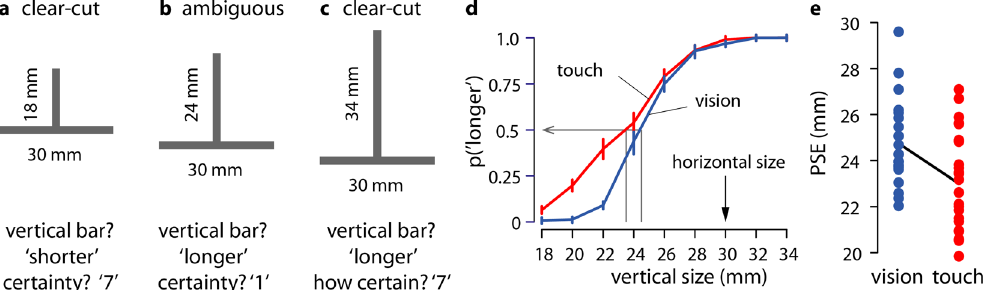
Figure 1. The Vertical-Horizontal Illusion ( a–c ) showing Inverted T stimuli were explored by touch and by vision. The vertical bar ranged from 18 to 34 mm, which was compared to a horizontal bar of fixed size of 30 mm. Stimuli could be clear-cut ( a , c ) or ambiguous ( b ) in the two modalities. Perceptual responses were verbal reports as to whether the vertical bar was ‘shorter’ or ‘longer’ than the horizontal bar. Confidence judgements were given on a scale from very uncertain (1) to very certain (7). ( a ) Probability of judging the vertical bar to be longer than the horizontal bar as a function of the size of the vertical bar. Error bars show within-participant standard errors. ( b ) Point of subjective equality (PSE) for each participant in each modality.